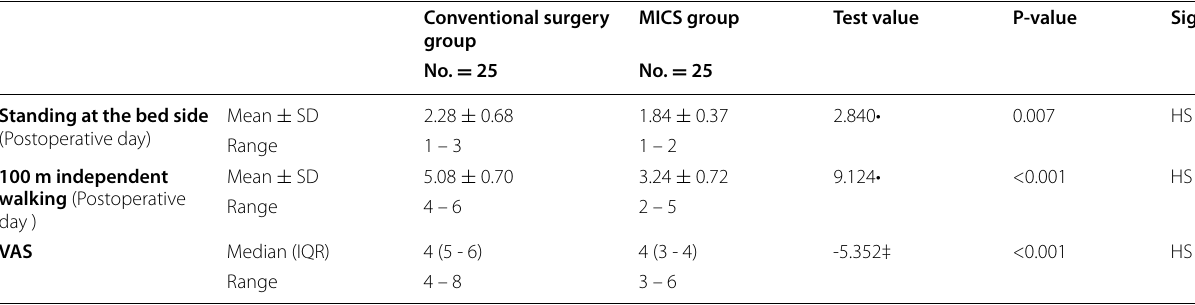
P is significant at